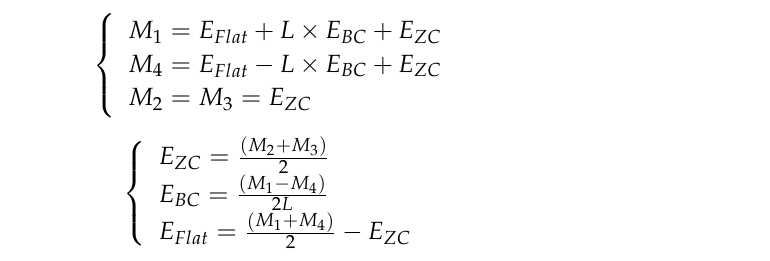
(c) Figure 11. Error separation of C axis axial error E ZC , tilt error E BC , and artefact profile error E flat . ( a ) Axial error E ZC , ( b ) Tilt error E BC , ( c ) Artefact profile error E flat . 4.3. Squareness Error between X and C Axes